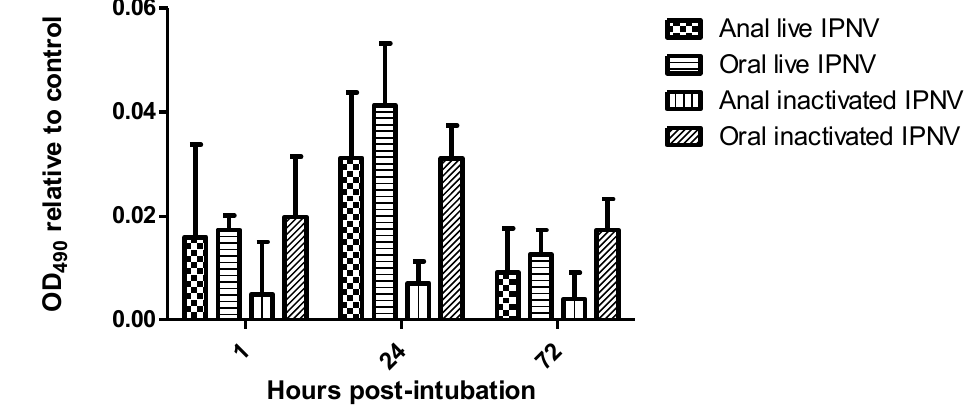
Figure 1. Infectious pancreatic necrosis virus in the serum of different groups of Atlantic salmon at different time points following intubation (using